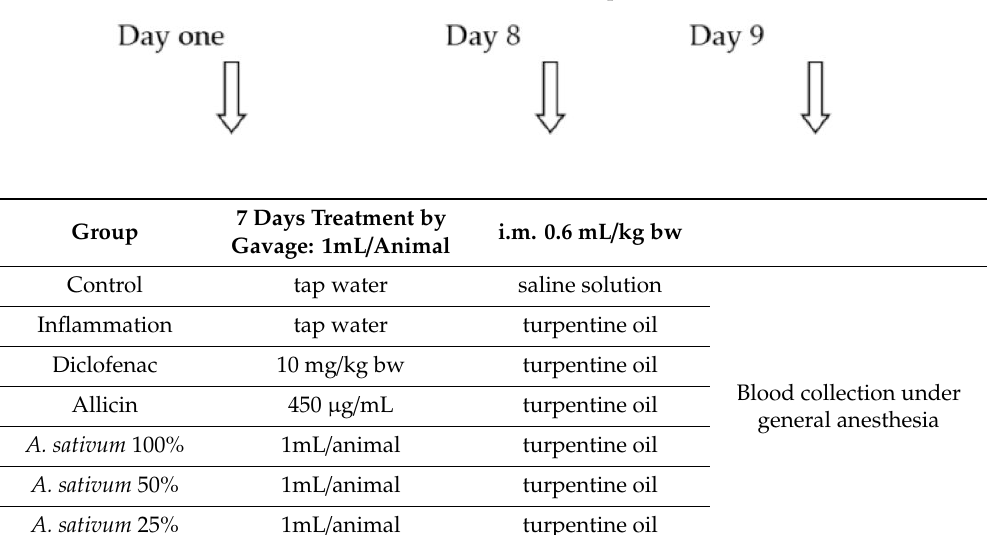
Table 4. Flowchart of the in vivo